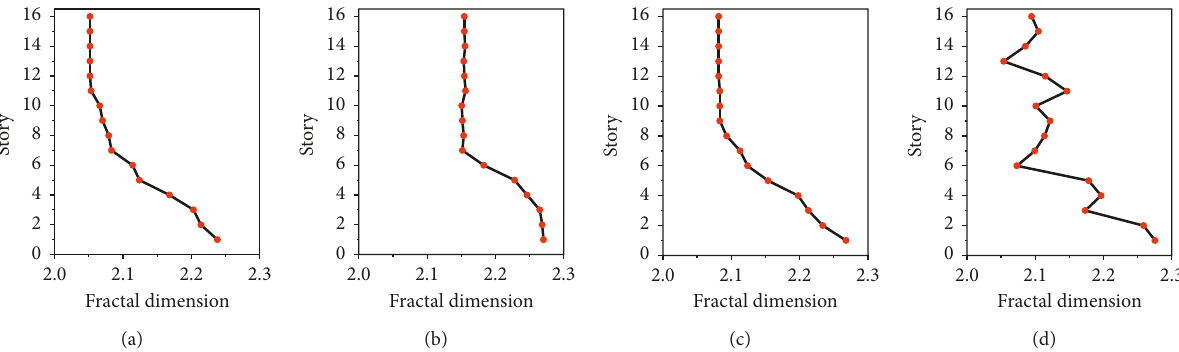
Figure 26: FDs of the TFFs of interstory displacements of the structure under strong ground motions when all the yielding stress of beams and columns as 205MPa. (a) Chichi, (b) Kobe, (c) Parkfield, and (d)